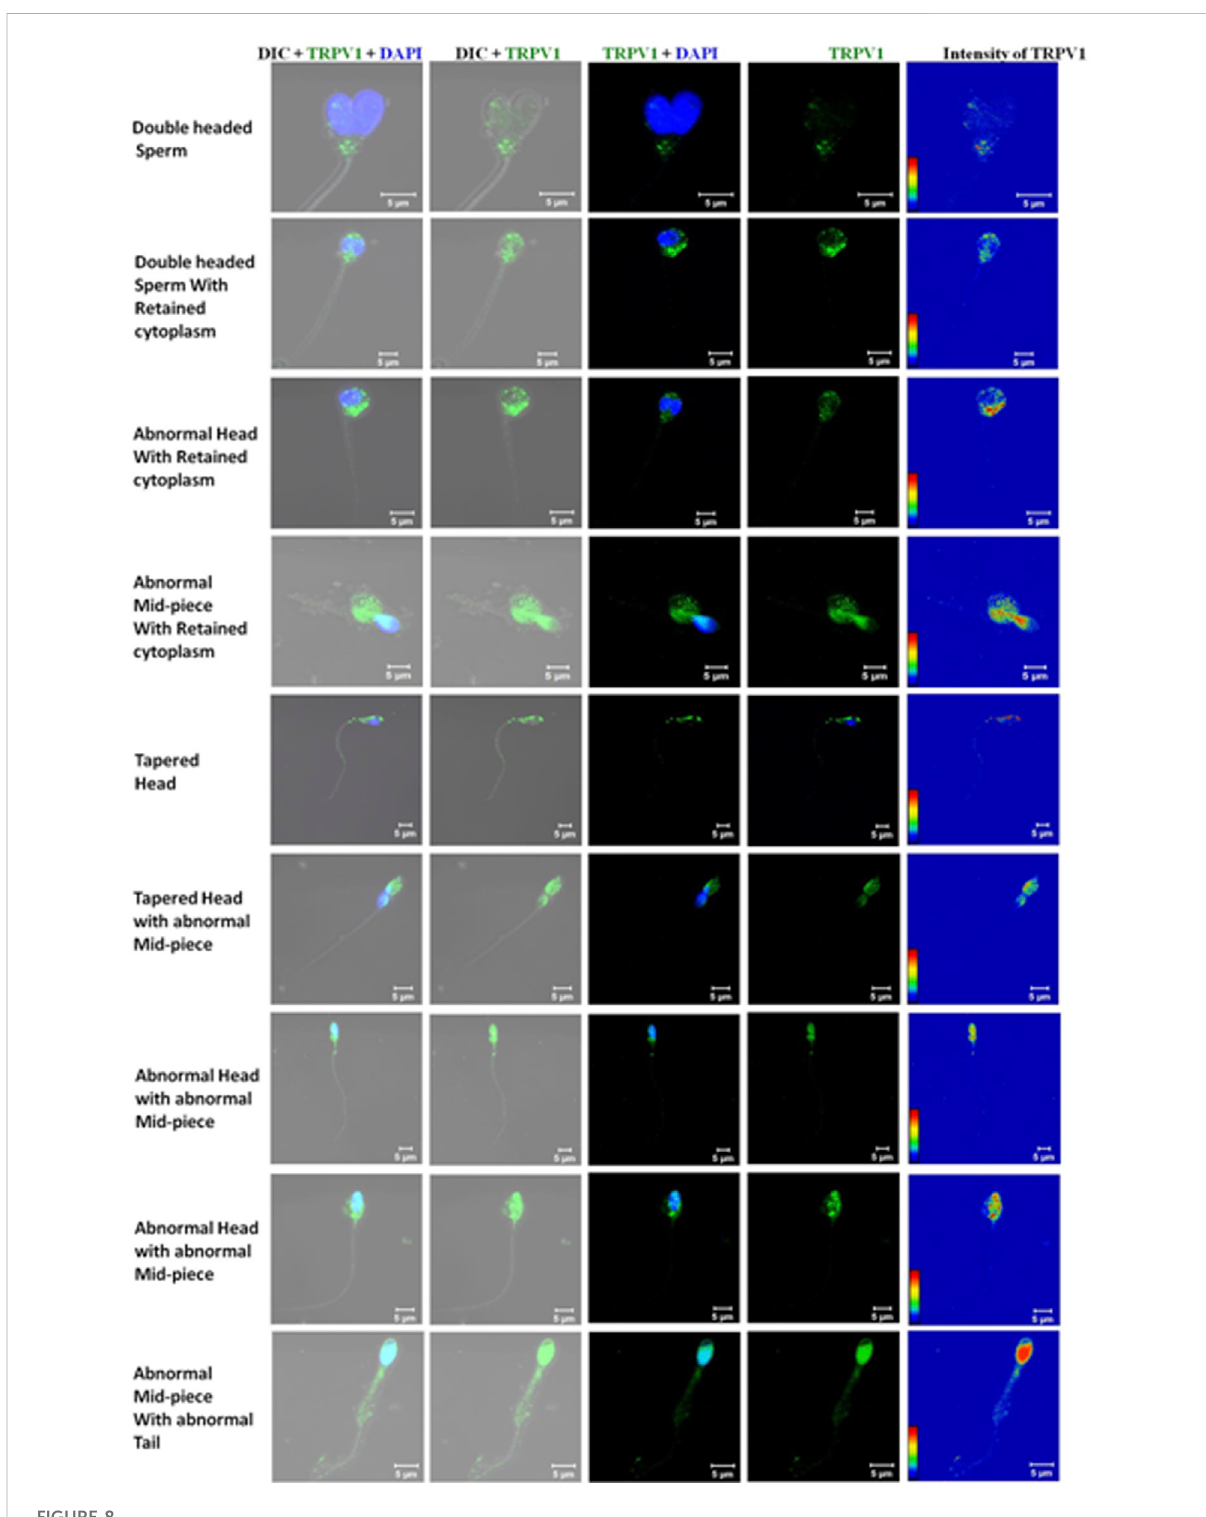
Representative confocal images (63X) showing the expression pattern of TRPV1 in different types of abnormal spermatozoa (morphological abnormality in one of more regions like head, mid-piece, or tail). Calibration bars are given within each